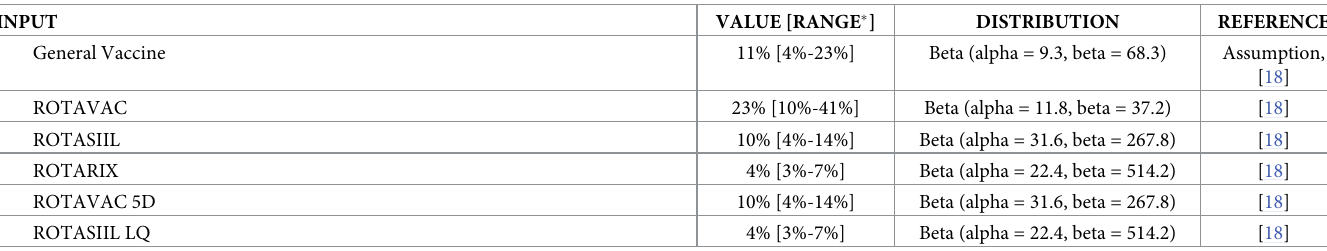
We estimated timing of projected deaths by combining overall rotavirus mortality estimates for each subpopulation and the estimated age distribution of diarrheal events from previous studies [24,36]. We estimated monthly rates for the first year of life and annual rates for the subsequent four years of life. To estimate rotavirus burden ( D ) for each subpopulation ( r , q ), ) across subpopulations by multiplying them by the we distributed national mortality rates ( M n normalized average risk scores for each subpopulation ( I , Eq 2.2). We then distributed the r , q fraction of deaths ( A ) occurring within the first twelve months and then the first four years of life ( t ) by multiplying it by the normalized diarrheal mortality risk estimate for each subpopu- lation ( M , Eq 2.1). r , q